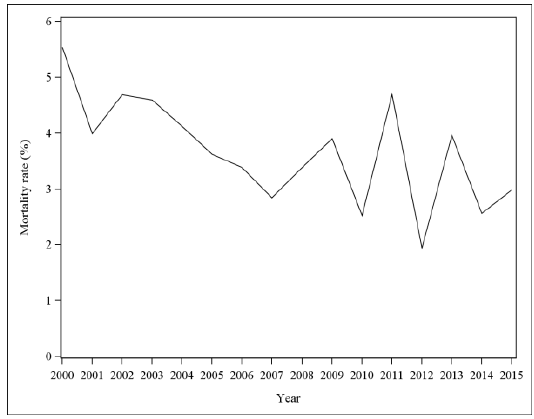
Figure 2- Mortality trend in tertiary surgical unit from